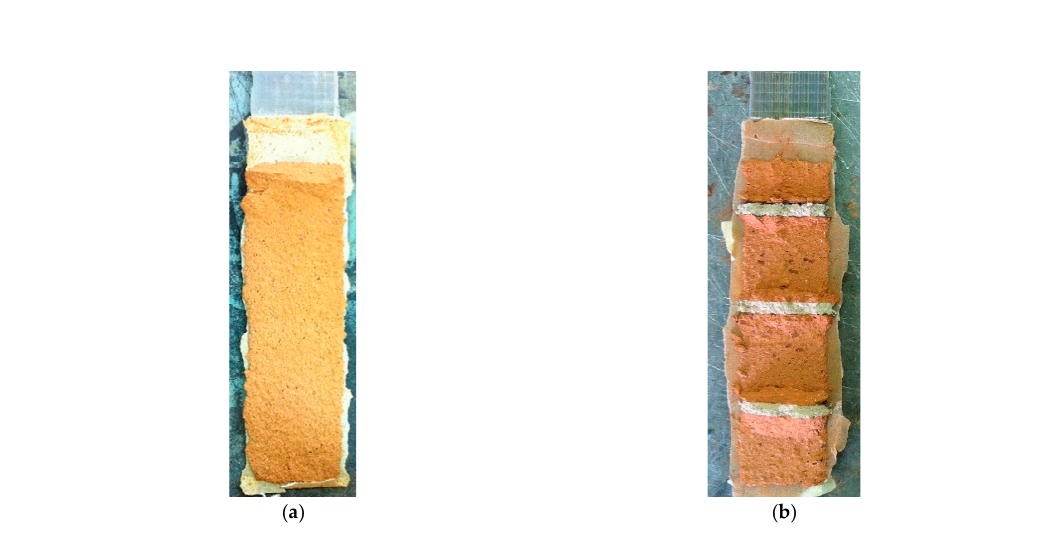
Figure 10. SRP detached from ( a ) clay unit; ( b ) clay masonry unit.